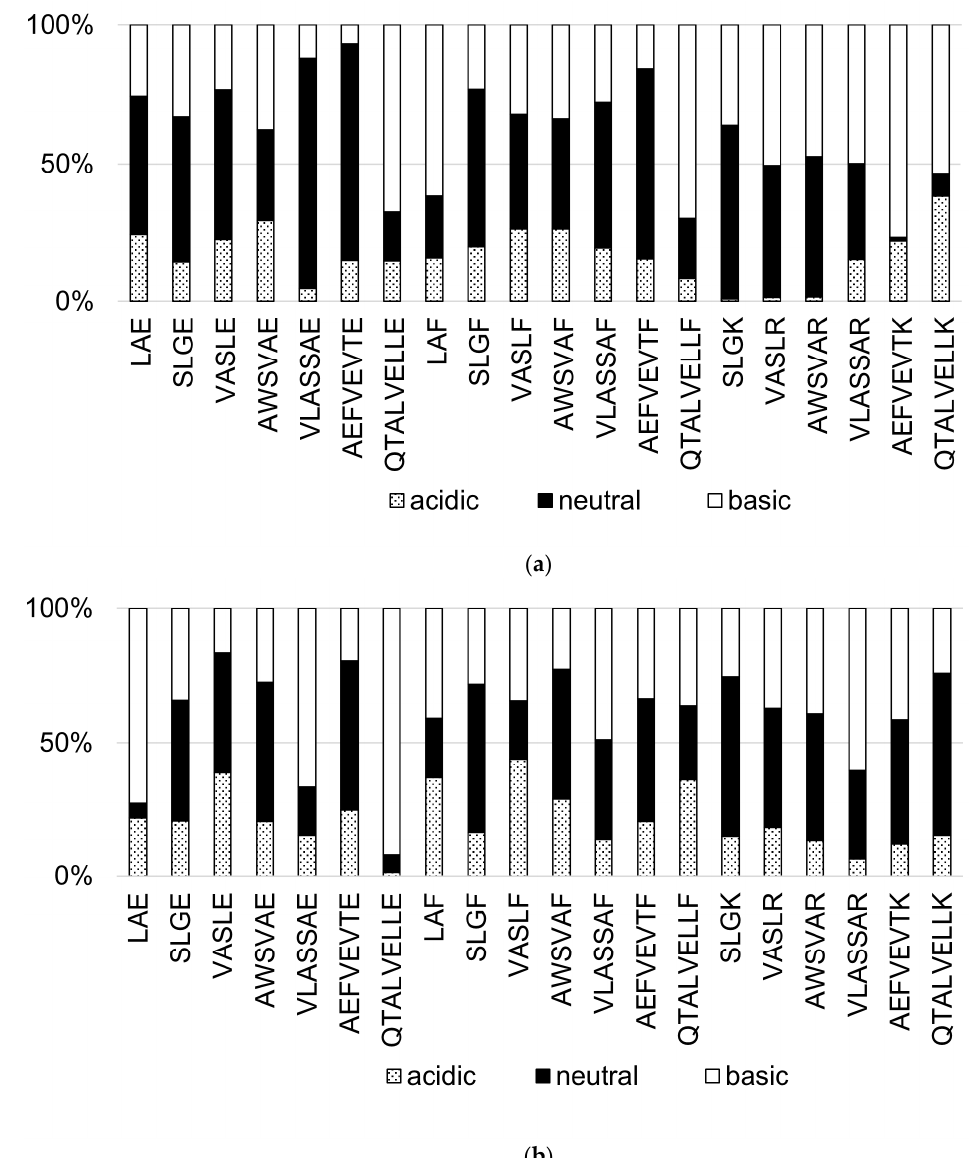
Figure 6. Normalized values of signal-to-noise ratio (S/N) for [M + H] + of peptide standards in the acidic (35 µ mol · L − 1 CH 3 COOH pH 3.8), neutral (water) and basic (35 µ mol · L − 1 NH 4 OH pH 10.5) mobile phases. ( a ) APCI and ( b )